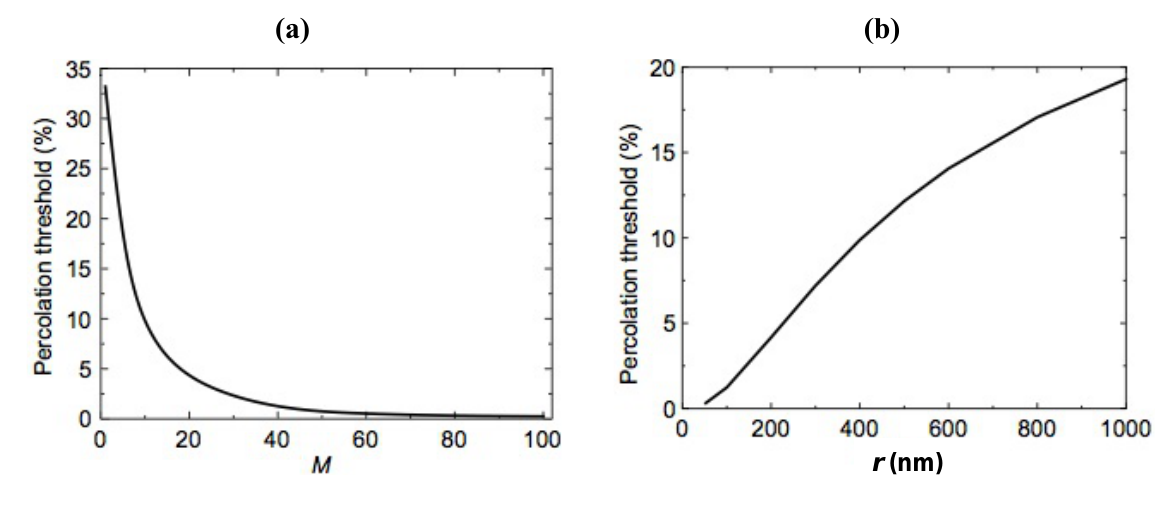
Figure 31. Percolation threshold versus ( a ) axial ratio M and ( b ) radius of conducting particles r